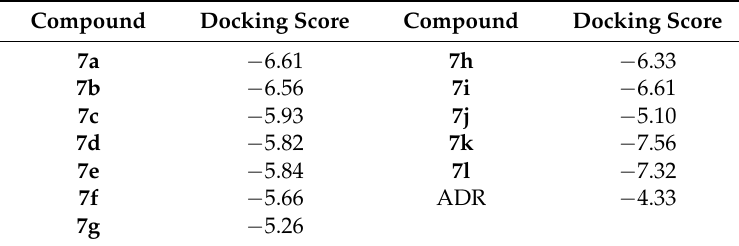
Table 3. Docking score of all the synthesized derivatives 7 ( a – l